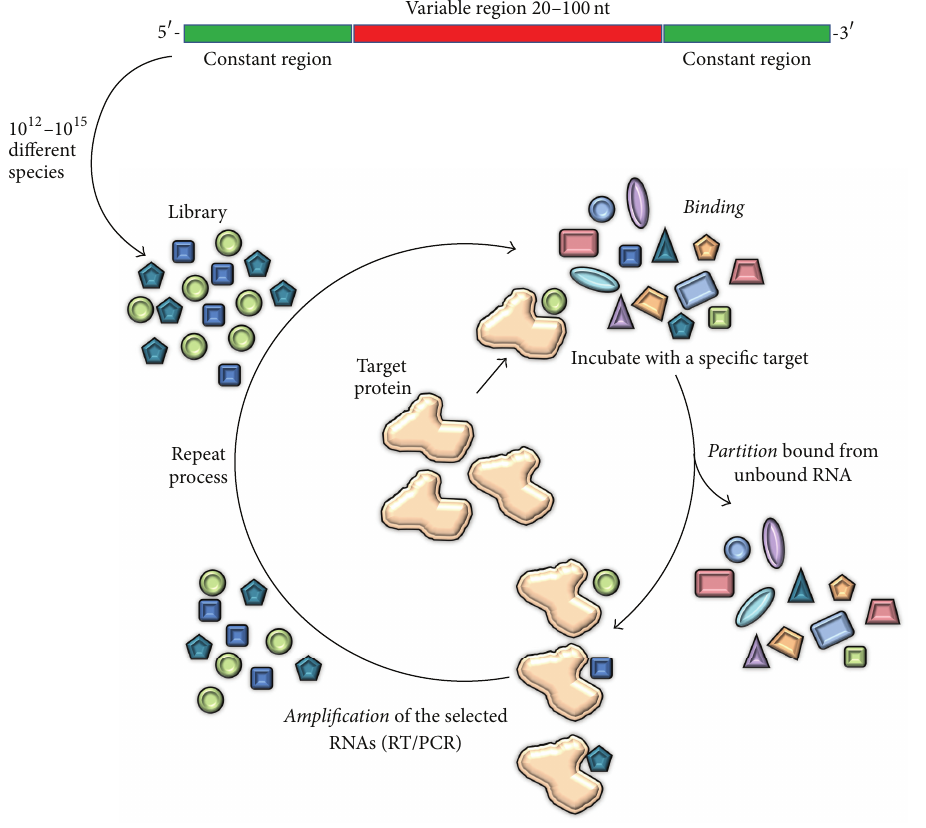
Figure 1: Schematic representation of SELEX